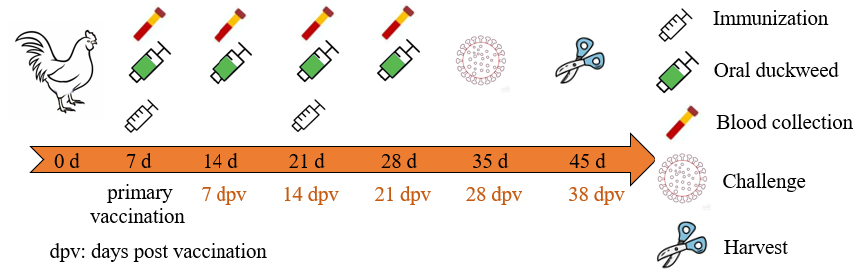
Figure 1. Timeline for vaccination, challenge, blood, and tissue sampling schedules.